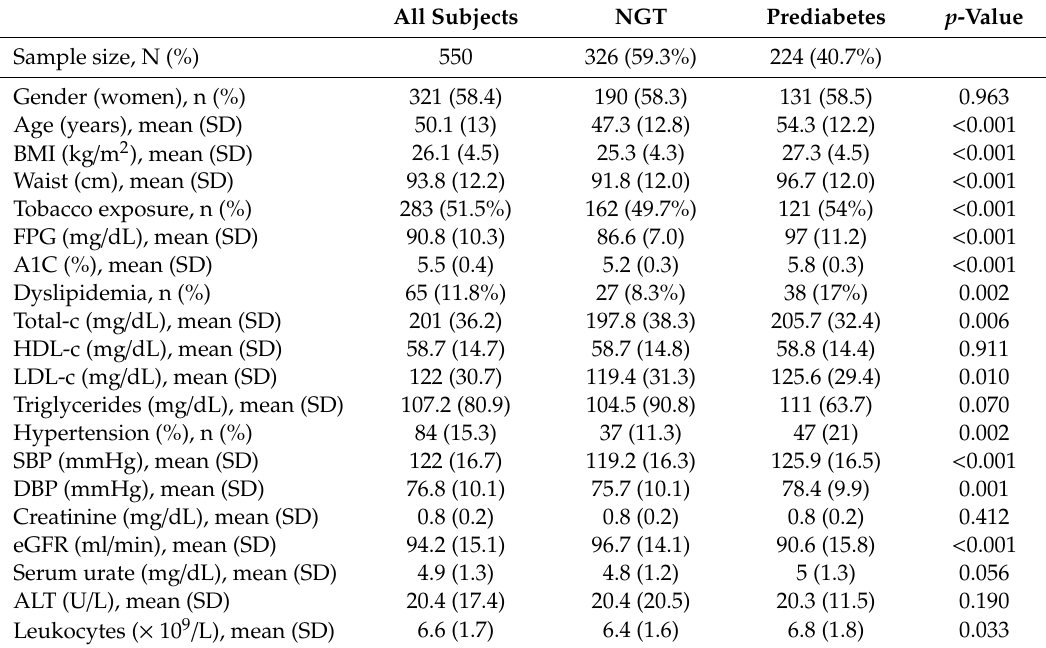
Table 1. Sociodemographic and clinical characteristics of the subjects included in the study. All Subjects